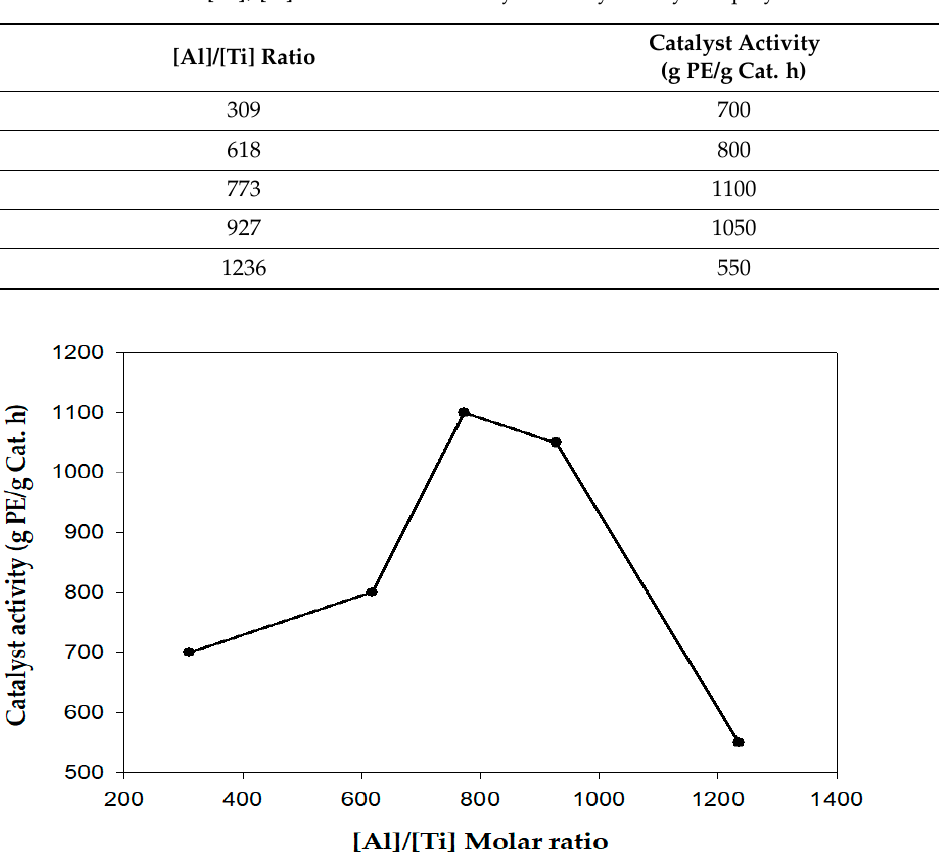
Figure 1. Variation of catalyst activity as a function of [Al]/[Ti] molar ratio in ethylene polymeriza-